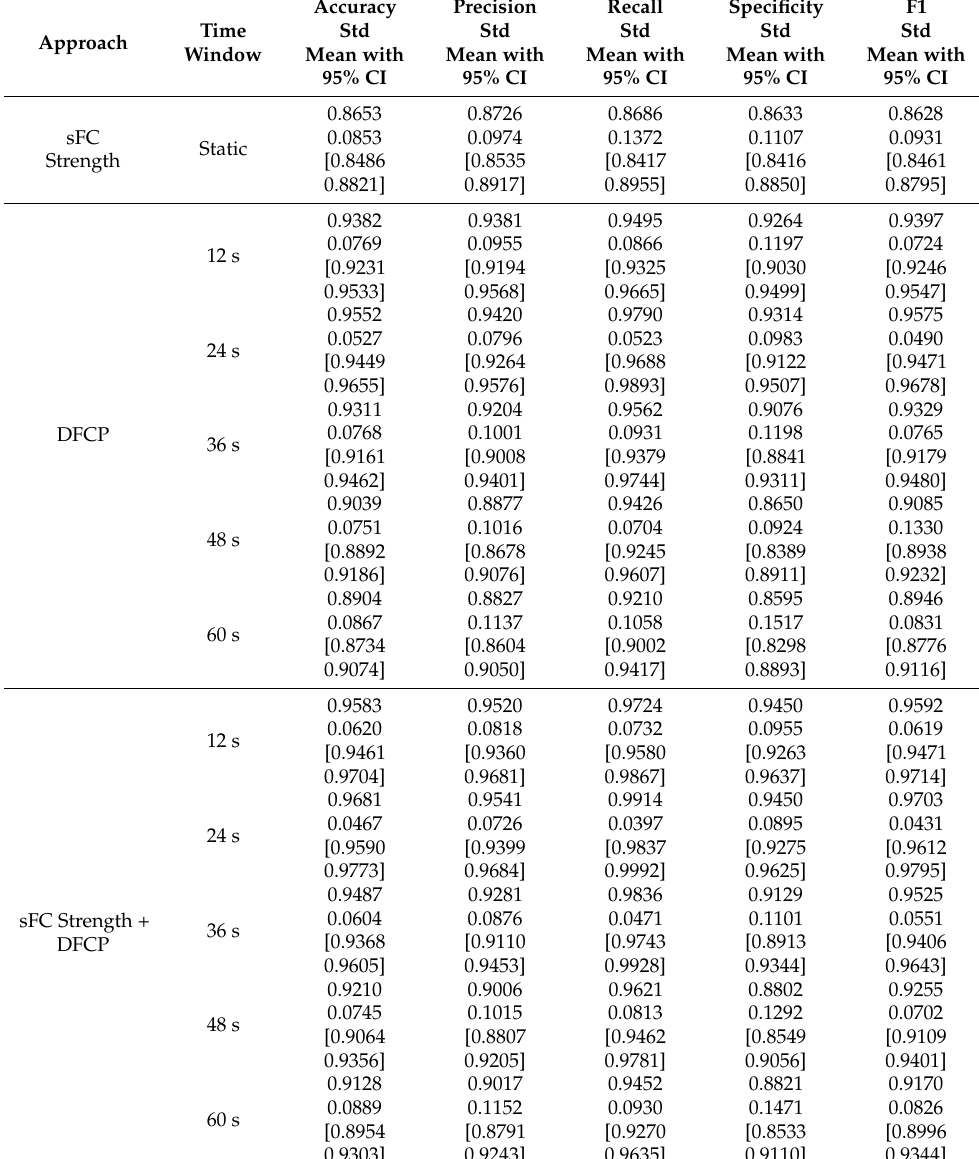
Table 1. Performance evaluation of classifier using different classification approaches for COBRE dataset.